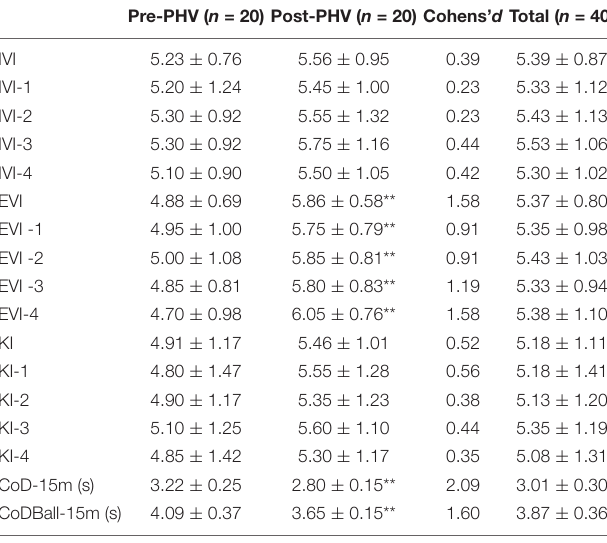
TABLE 2 | Performance variables for movement imagery questionnaire for each item (IVI, EVI, and KI), and the CoD performances (CoD-15m and CoDBall-15m) according to maturity